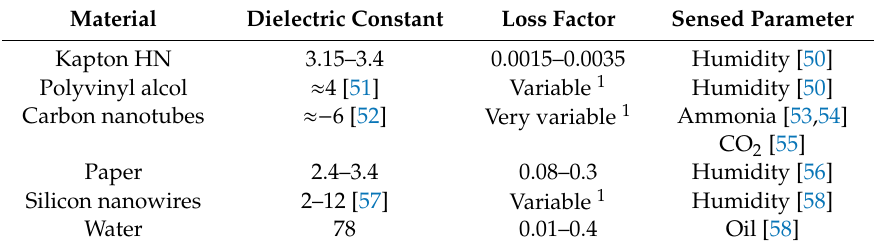
Table 1. Dielectric properties of typical sensing